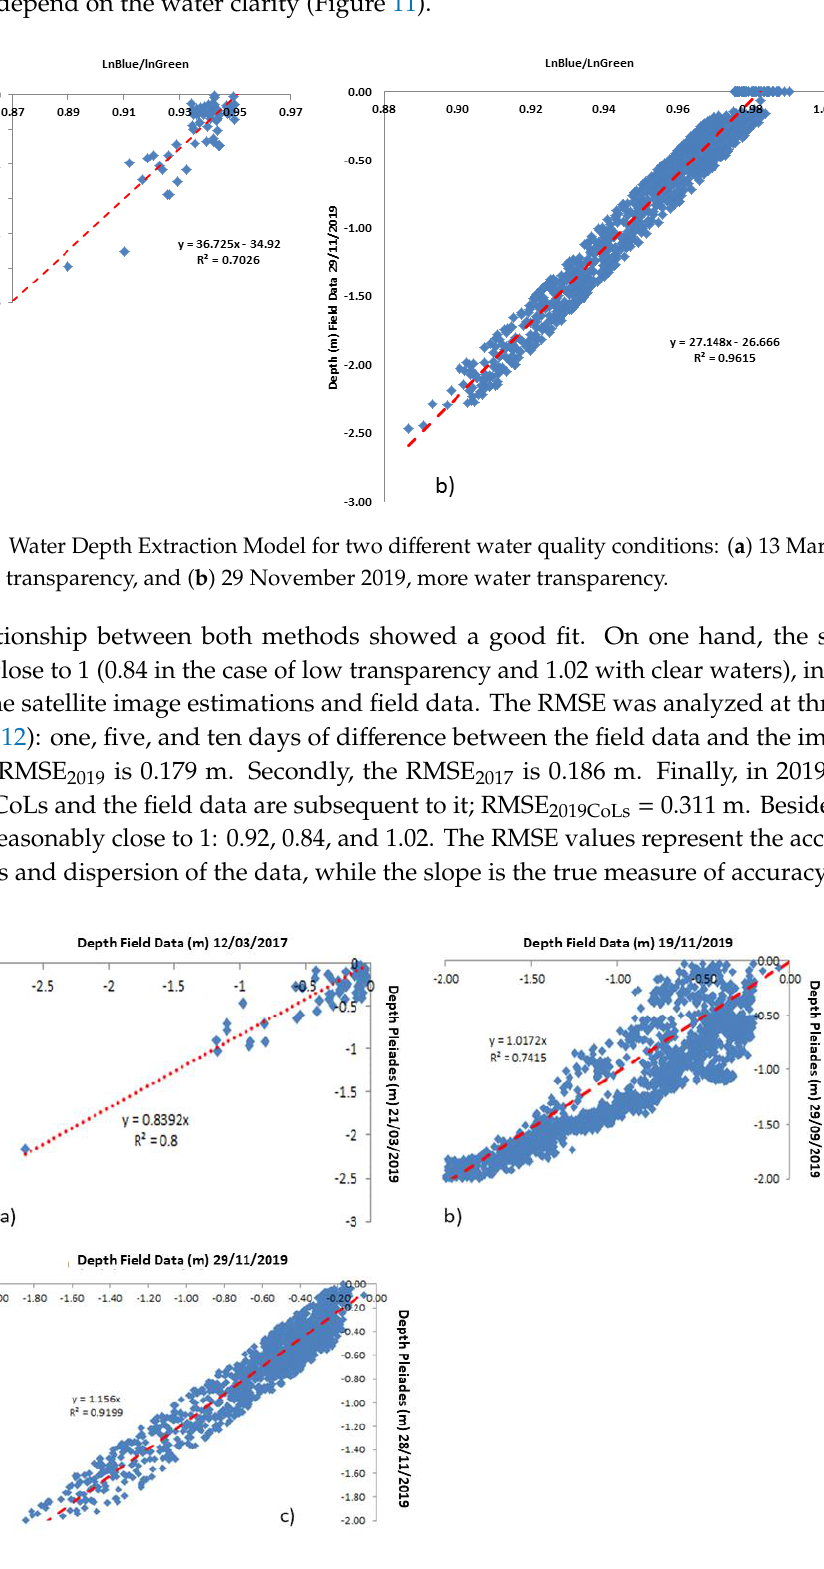
Figure 12. Relationships between field and image data at three different dates: ( a ) 21 March 2017; ( b )